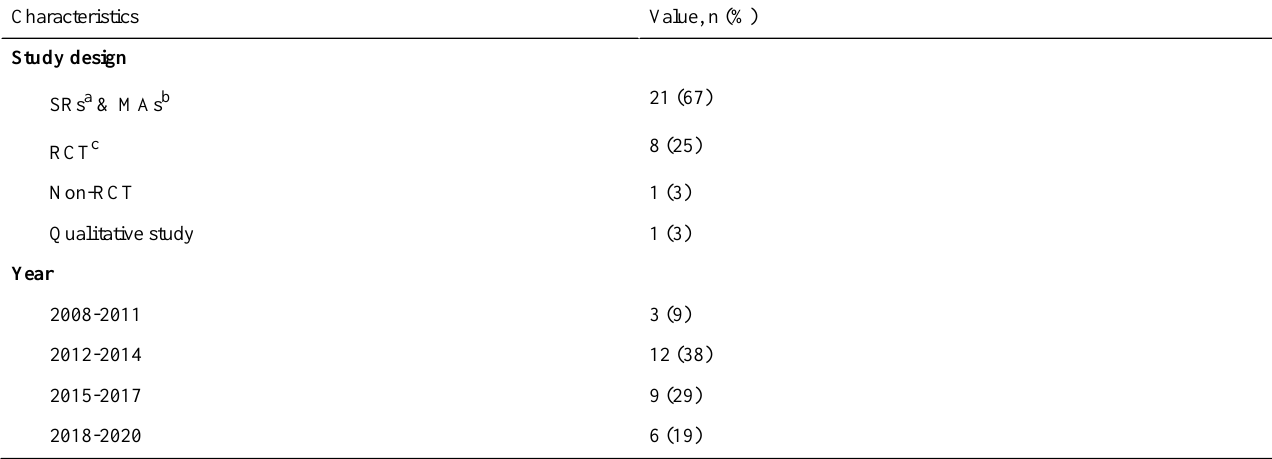
Table 1. Baseline characteristics of all studies (n=31).